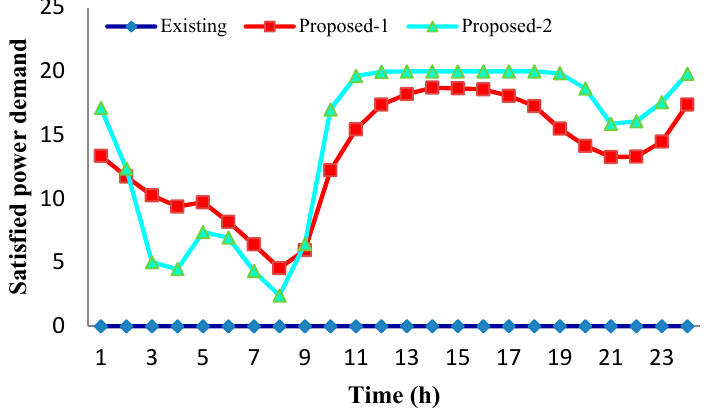
Figure 11. Satisfied power demand management between existing and proposed scenarios over 24 h time